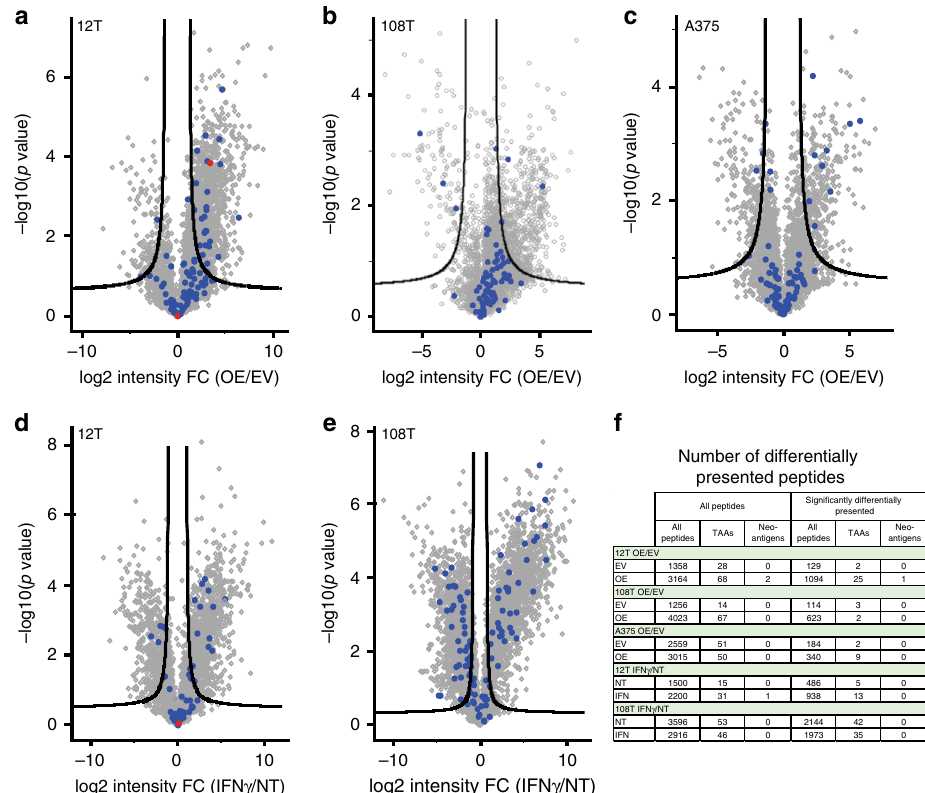
Fig. 3 Differently presented peptide repertoire in cells with immunoproteasome overexpression. Volcano plots were plotted to identify the peptides that were differentially presented by cells with overexpression of the immunoproteasome subunits (OE) compared to the control (EV) ( a – c ), or of the cells that were treated with IFN γ (IFN γ ) compared to non-treated cells (NT) ( d , e ). Each HLA peptidomics experiment was done on three independent cell cultures. Peptides were determined as signi fi cantly changed if they passed statistical analysis (Two side student ’ s t-test, permutation based FDR = 0.05, S0 = 1) and were found in the plot above the lines. TAAs were marked in blue dots and neo-antigens in red dots. The number of differentially presented peptides is indicated in the table ( f